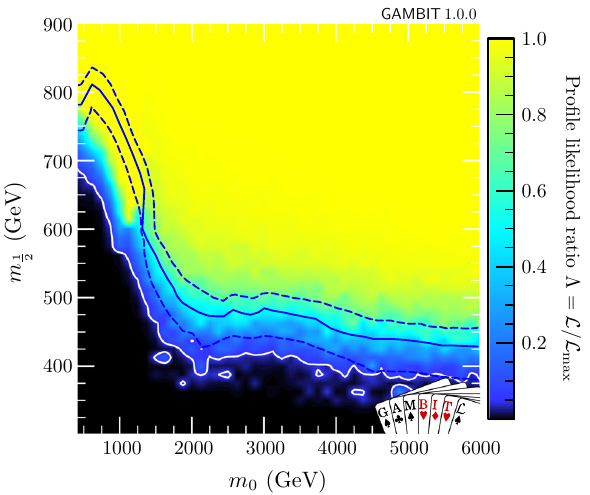
Fig. 3 Output from a ColliderBit CMSSM grid scan over m 0 and m 1 / 2 with tan β = 30, A 0 = − 2 m 0 and μ > 0, using 50 grid points in each direction. The likelihood only includes the ATLAS zero lep- ton SUSY search, with 20,000 MC events generated per point. The colour map shows the profile likelihood ratio L / L max and the solid white line indicates the GAMBIT 95% CL exclusion contour, defined by L / L max = 0 . 05. The blue solid line shows the ATLAS 95% CL observed exclusion limit, taken from Ref. [49], with the blue dashed lines showing the reported ± 1 σ theoretical (cross section) uncertainty